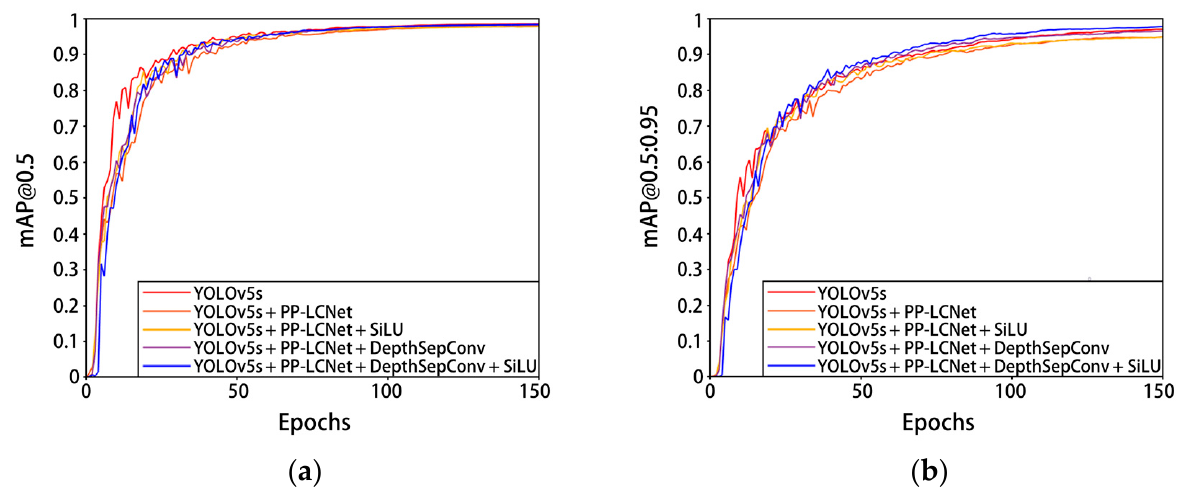
Figure 10. Experimental results of each improved YOLOv5s model on the Penaeus vannamei dataset. ( a ) The change in curve in mAP@0.5; ( b ) the change in curve in mAP@0.5:0.95. Table 4. Improvement and comparison of